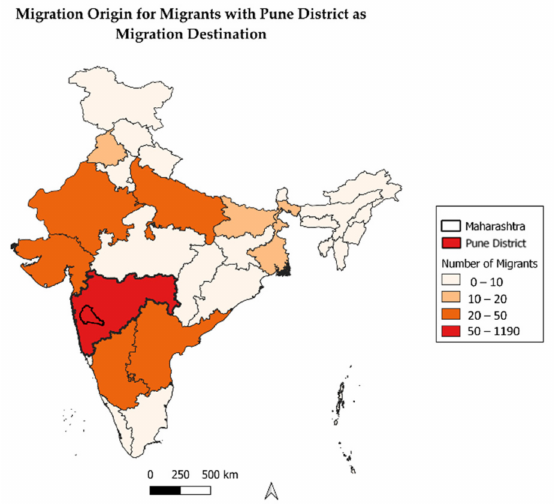
Figure 1. Total number of Pune District migrants per state of origin in 64th NSSO round 2008 ( n = 1438)